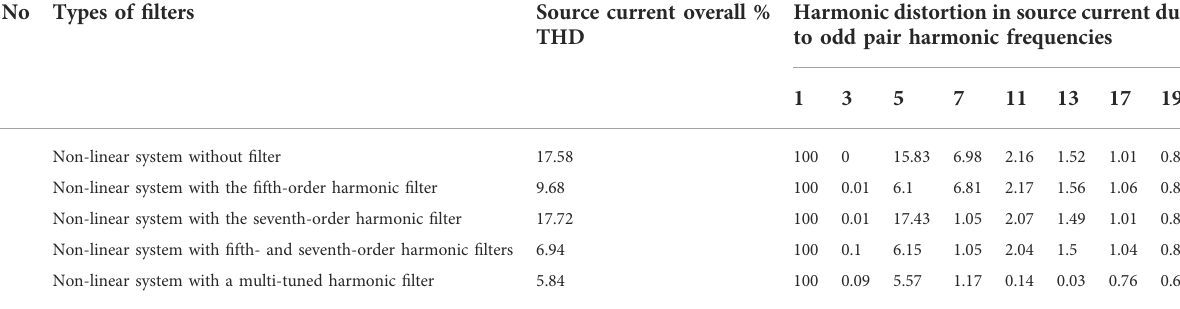
TABLE 6 % THD for various types of passive fi lters.